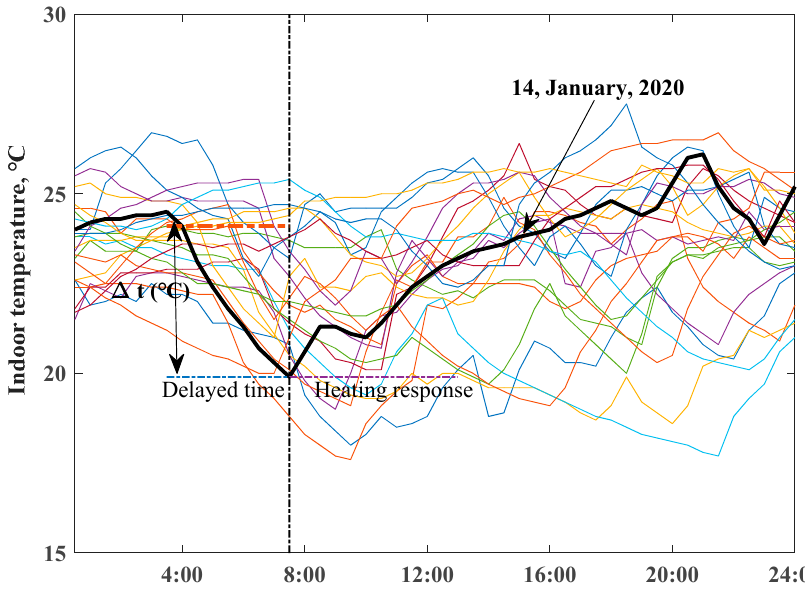
Figure 6. Daily indoor air temperature profiles of ZEH 1, bold black line presents the selected typical day.